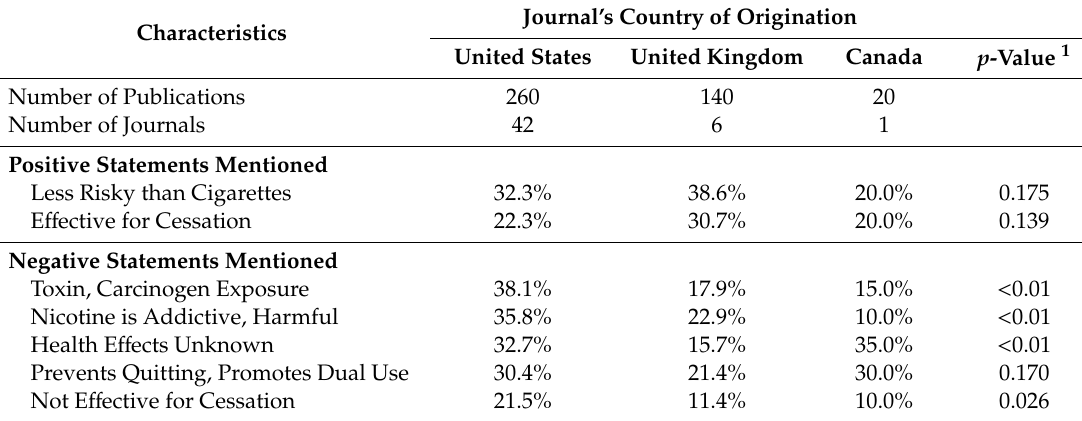
Table 2. Percentage of electronic nicotine delivery system publications with specific belief statements and characteristics, stratified by core clinical journal’s country of